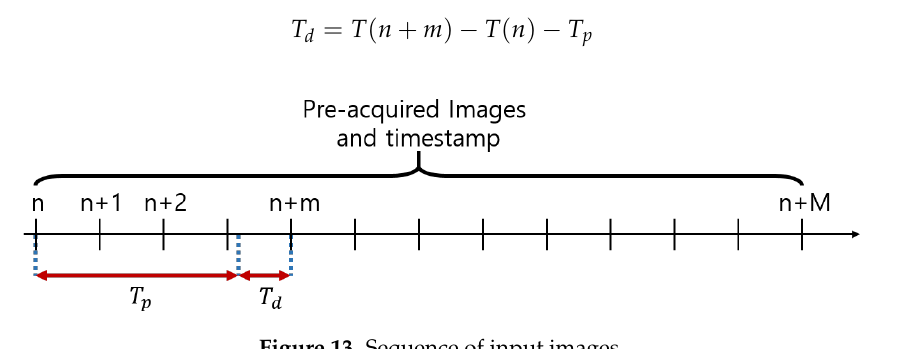
Figure 13. Sequence of input images.